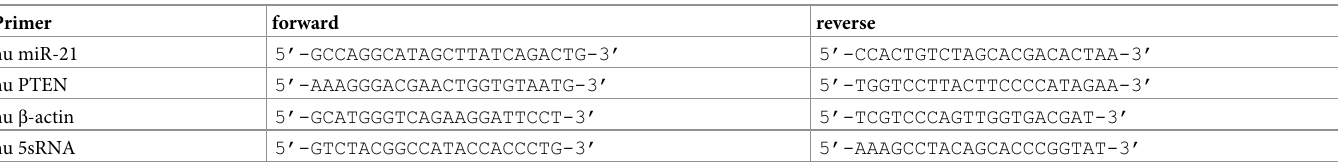
Table 2. The constructed primers of miR-21 and PTEN for Q-RT-PCR.